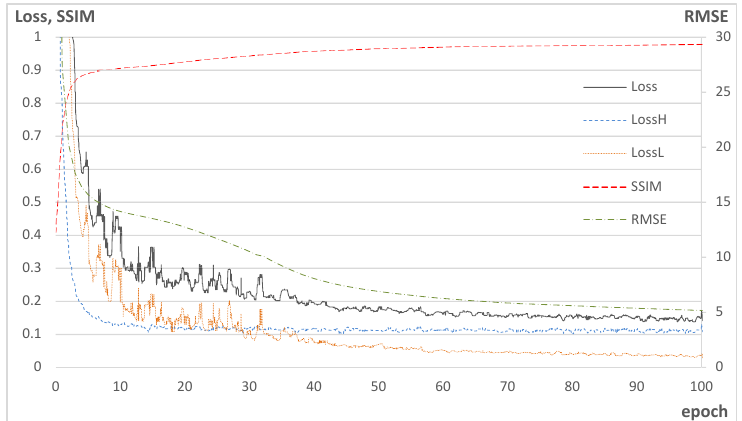
Figure 5. Learning curves of training (losses for training data, SSIM and RMSE for test